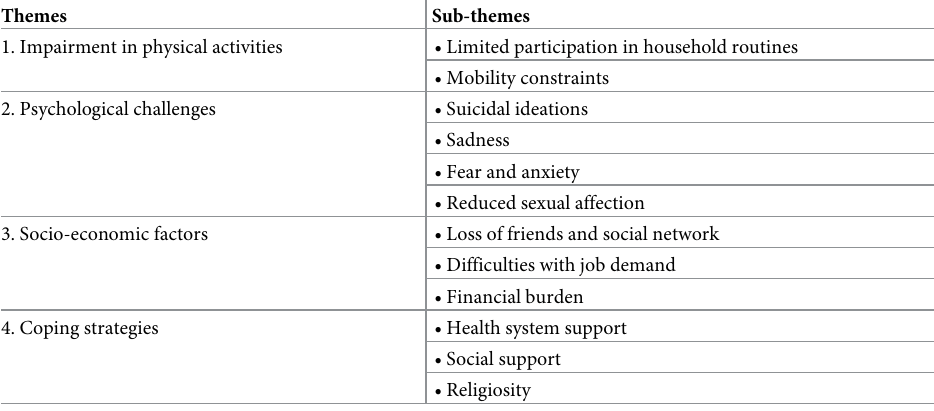
Table 1. Summary of themes and sub-themes from the transcribed